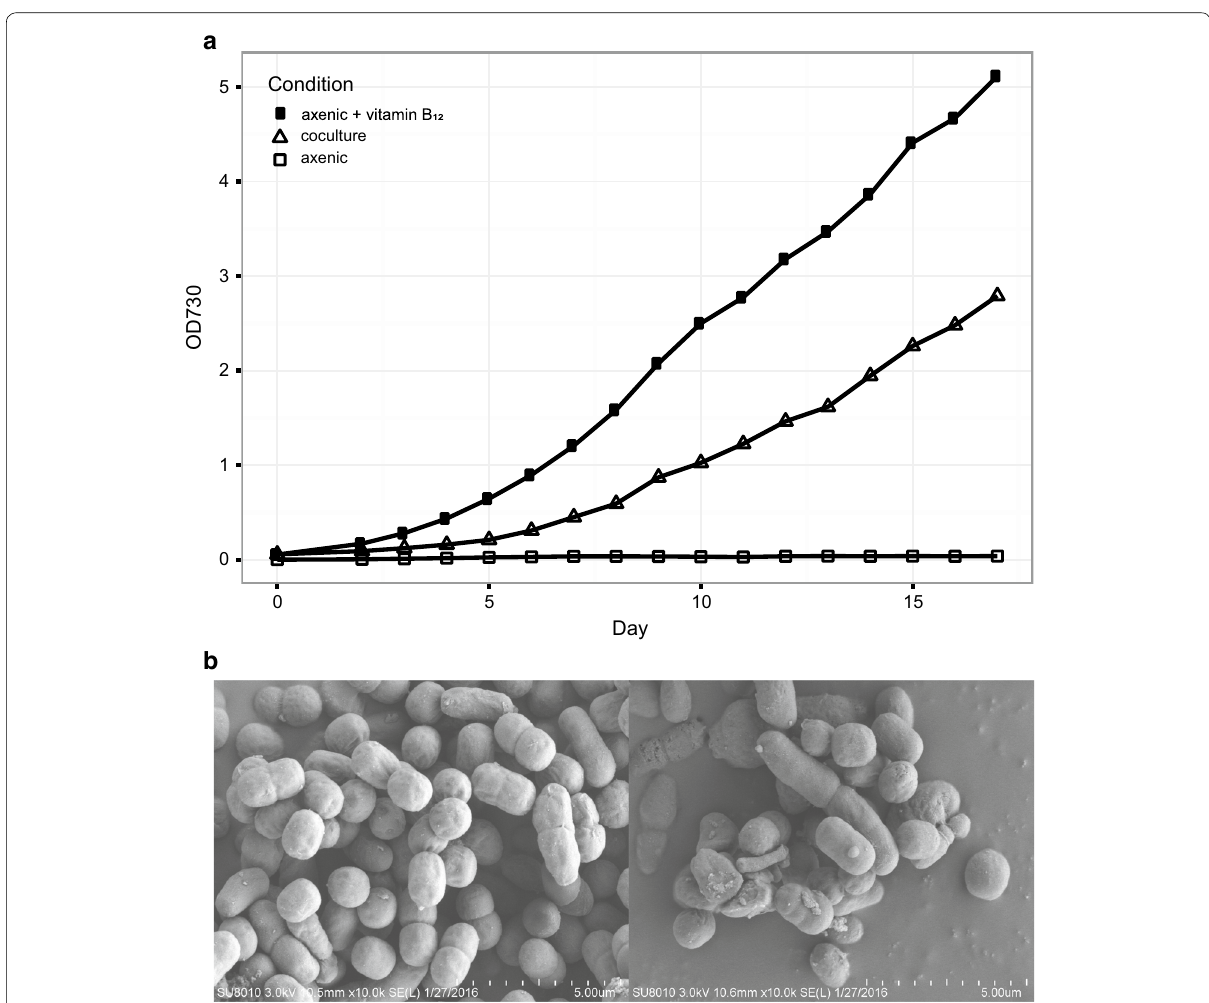
Fig. 2 The comparison of algae cell in coculture and axenic culture. a The growth curve of algae cell in coculture (open triangles), axenic Synechoc- occus sp. PCC 7002 in the presence (filled squares) or absence (open squares) of vitamin B 12 . The basal medium of the cultures is BG11 medium (see “Materials and methods” section). Obviously, the axenic cyanobacterium is unable to grow in the absence of vitamin B 12 ; b the scanning electron microscopy (SEM) image of cells in coculture (bottom right panel) and axenic culture (bottom left